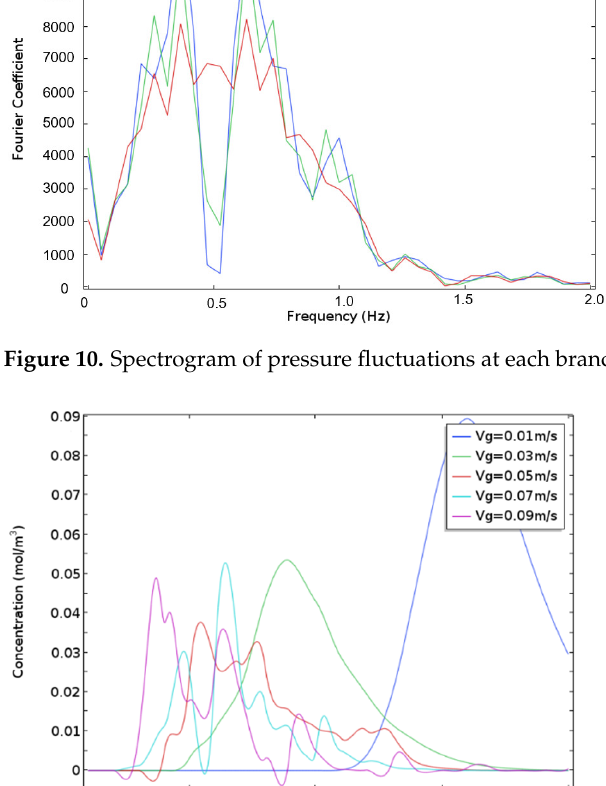
Figure 11. Tracer concentration at the reactor outlet versus time under different working conditions.